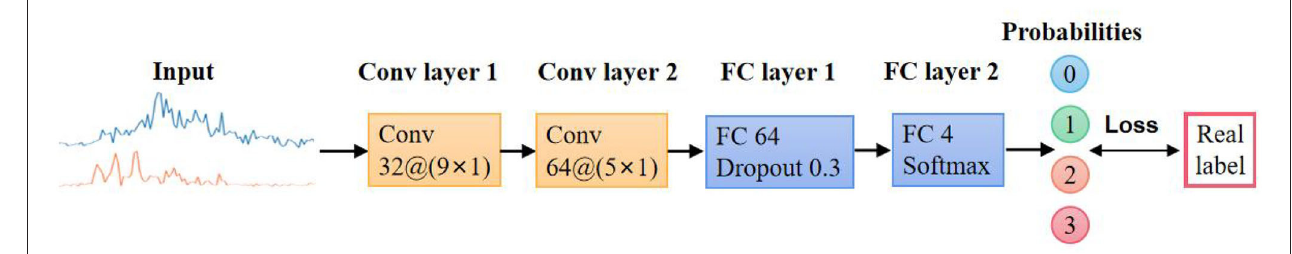
FIGURE 4 | Facial expressions’ classification model.